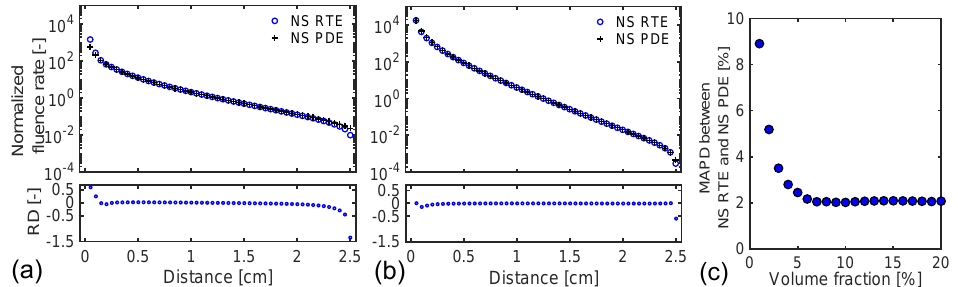
Figure 8. ( a , b ) Fluence rates calculated from the RTE and PDE at different positions. The RDs in the numerical results between the RTE and PDE are plotted in each figure’s bottom. ( c ) MAPD, D Φ ( N , R ; N , P ) , between the RTE and PDE at different volume fractions. The other details are the same as Figure